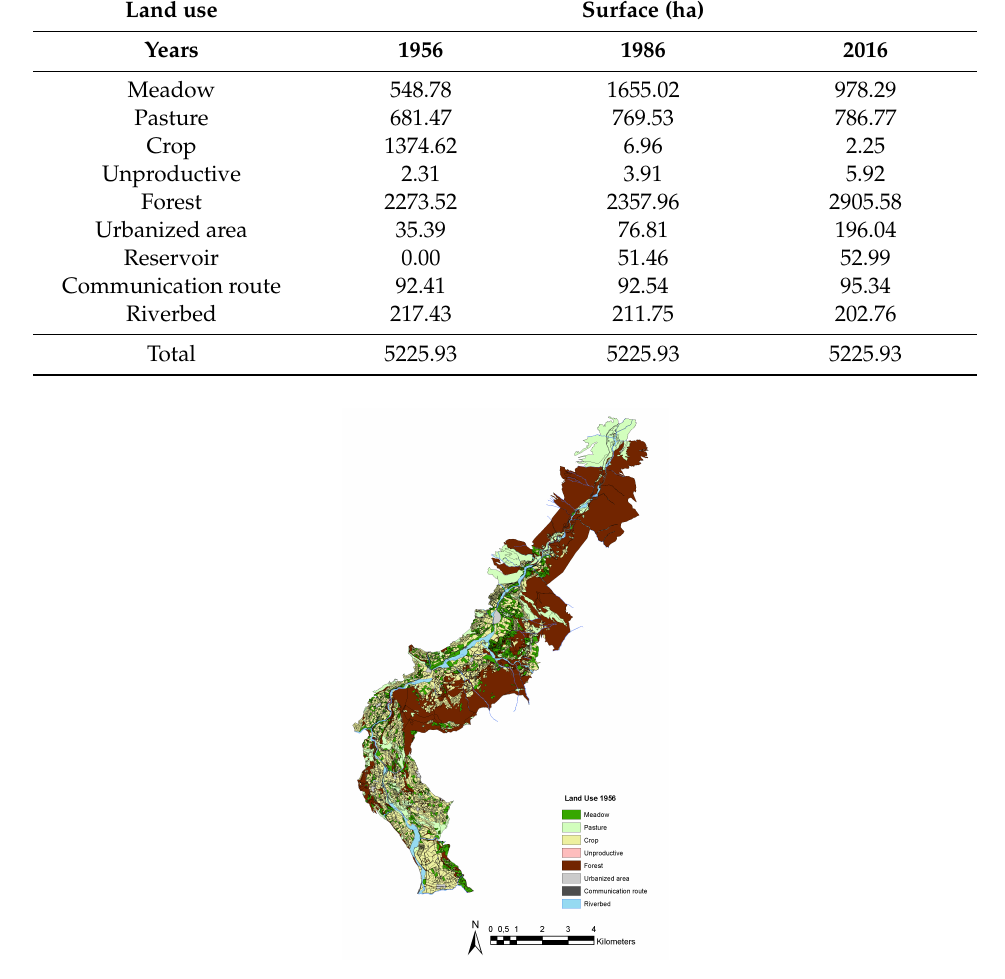
Figure 2. Land uses in